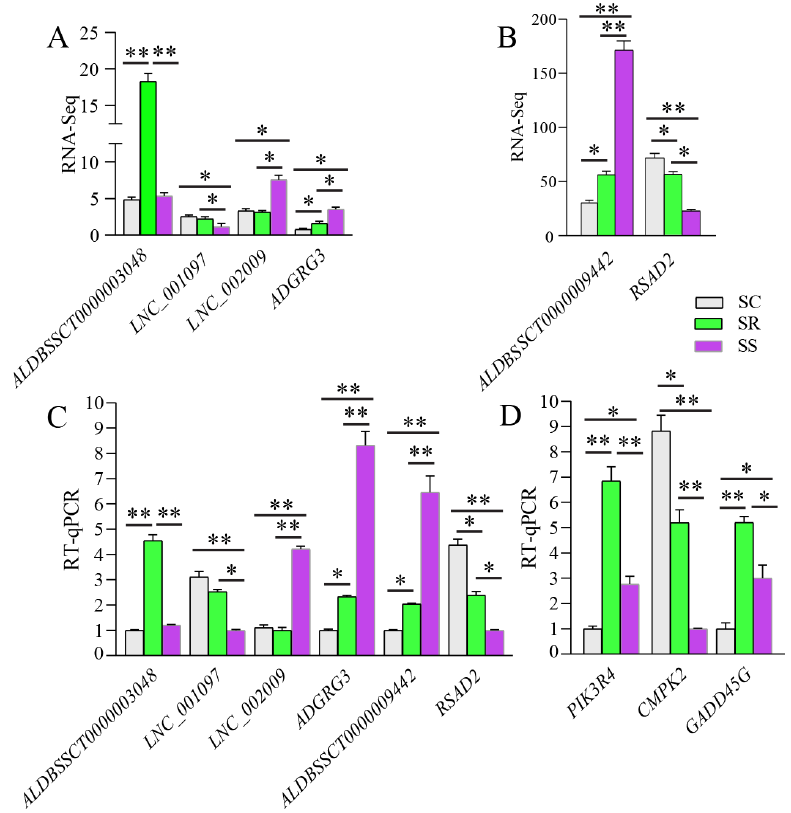
Figure 8. Validation of the reliability of RNA-Seq data and four gene expression levels. Data are presented as Mean ± SE with three duplicates. One-way ANOVA was performed to calculate statistical significance followed by Duncan’s test. Different asterisks above bars indicate significant differences (* p < 0.05, ** p < 0.01).